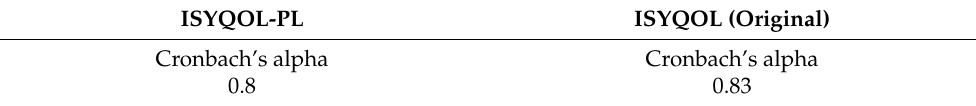
Table 2. The Cronbach’s alpha value coefficient of the ISYQOL-PL compared to the ISYQOL (original). ISYQOL-PL